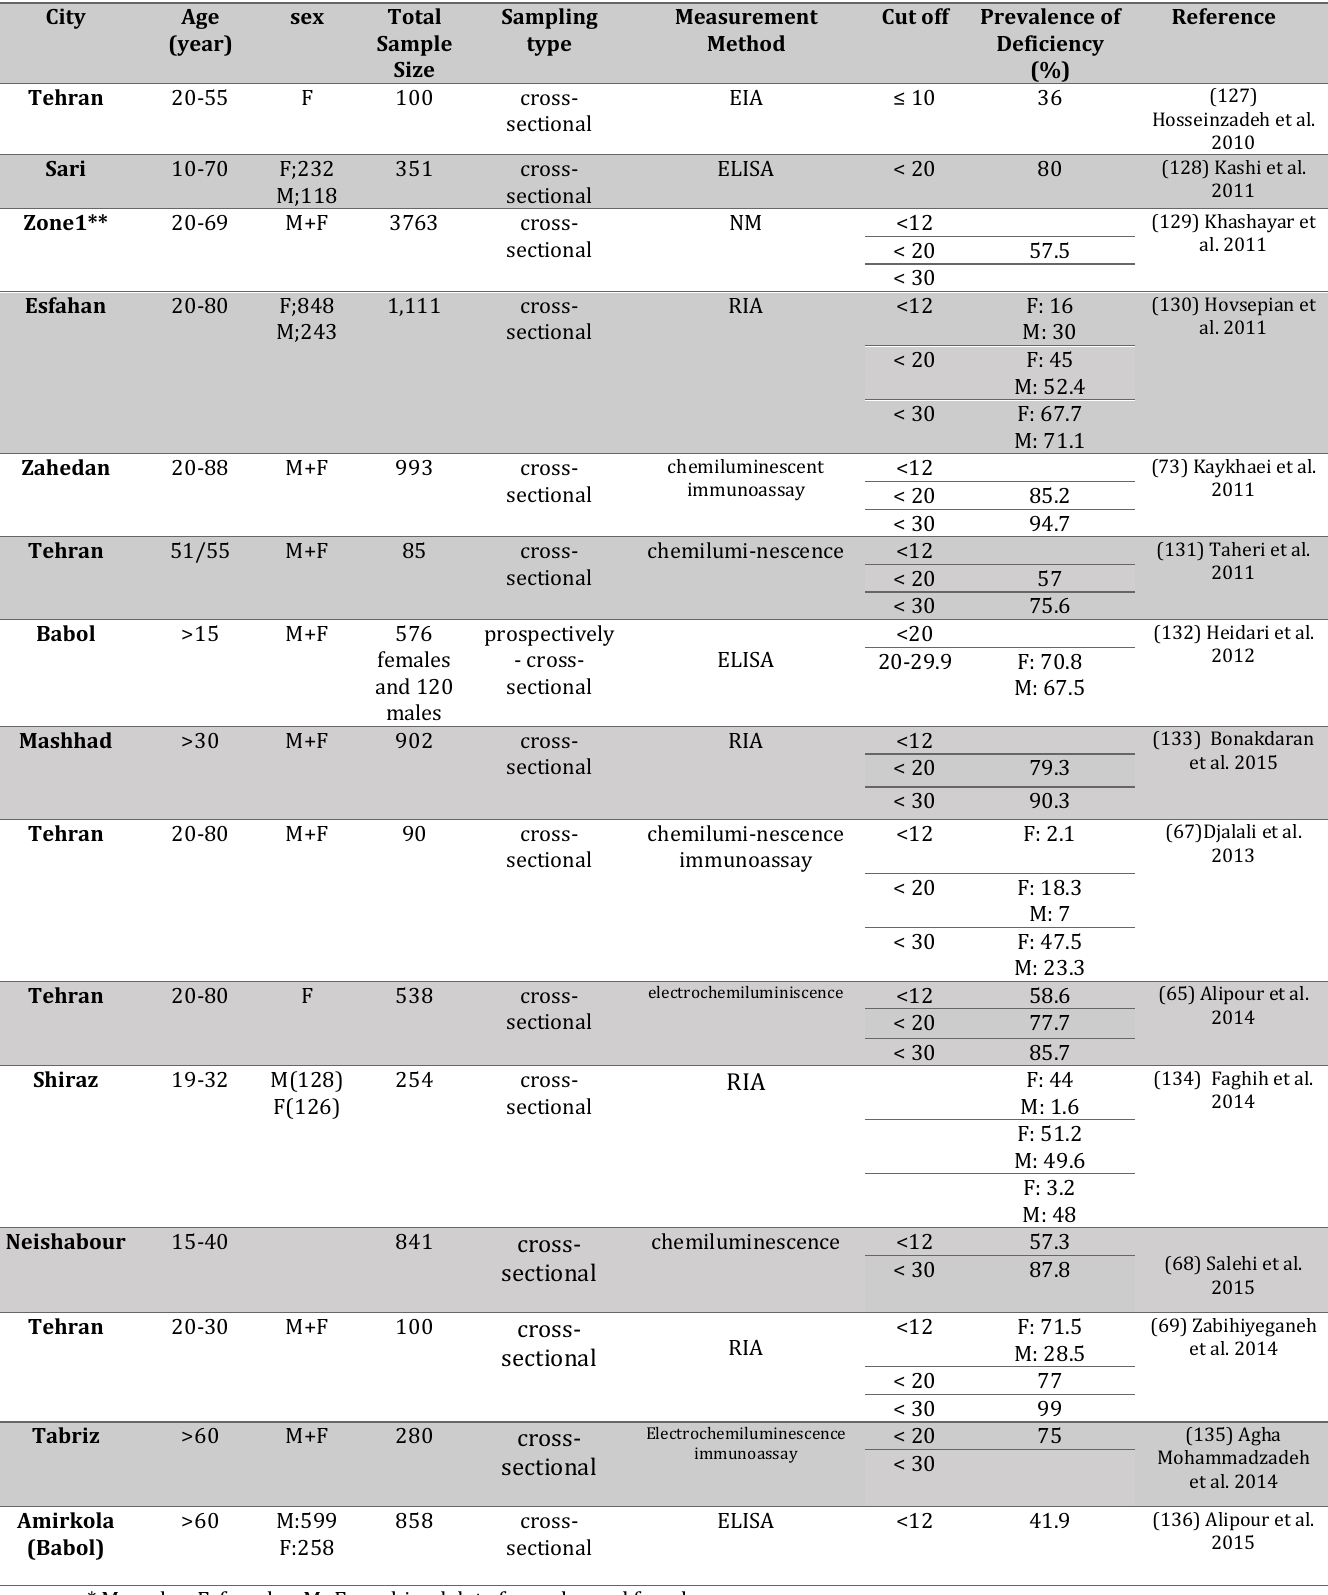
Continue Table 4. Characteristic and main results for the prevalence of vitamin D deficiency or insufficiency in Iranian children, adolescents, adults and